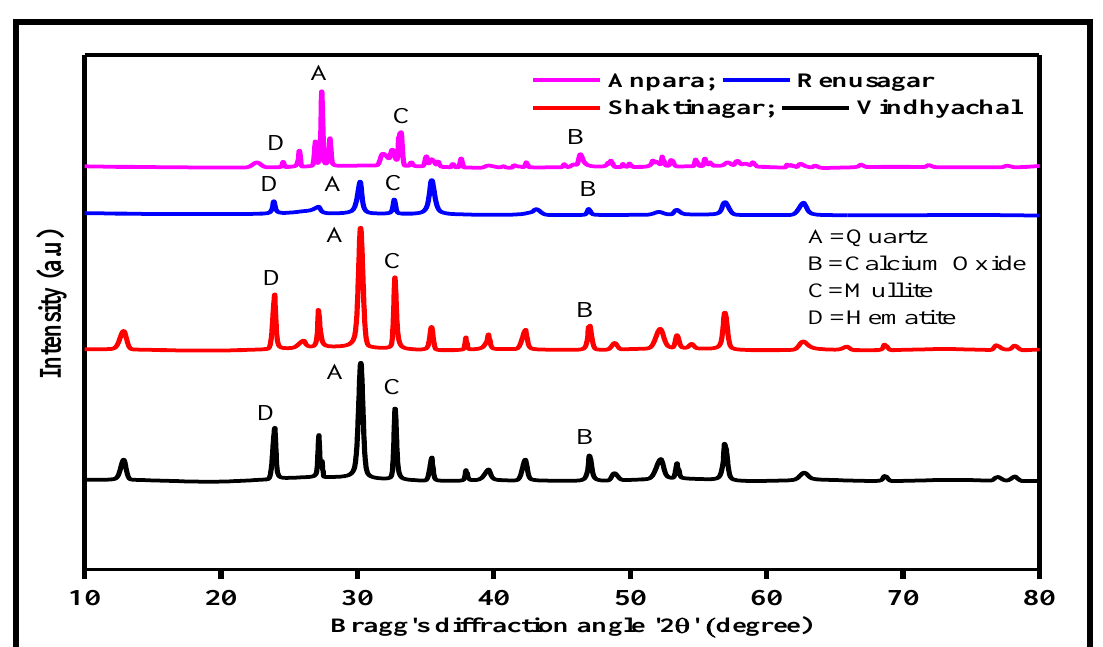
Figure 3. X-ray diffractograms of selective fly ash samples from various thermal power plants using the abbreviations for minerals followed by Kretz [33].